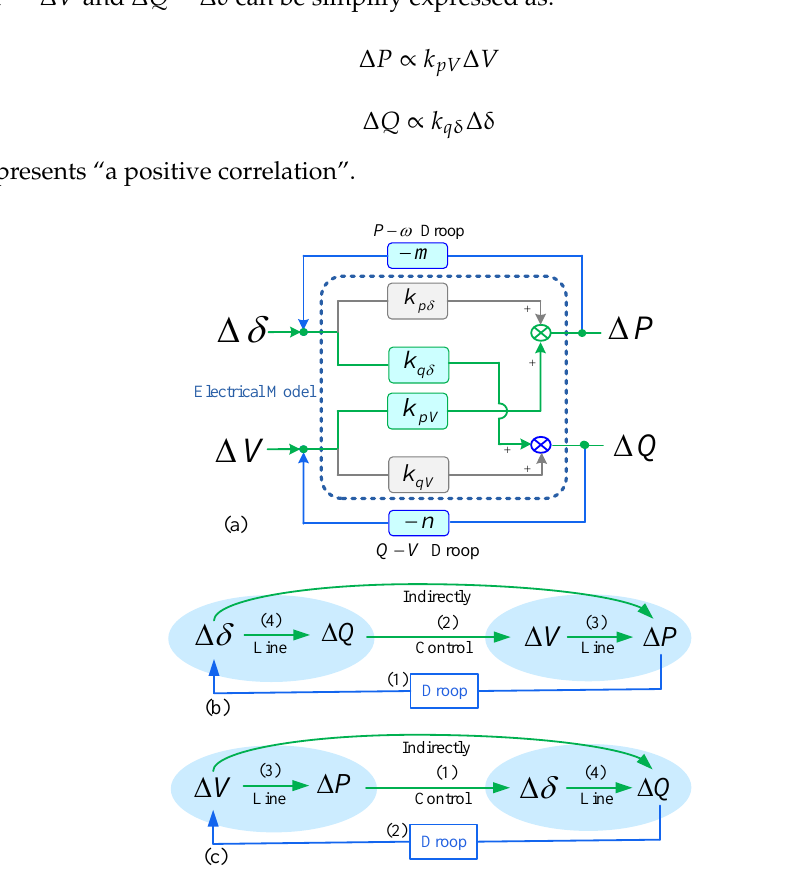
Figure 3. The coupling relationship: ( a ) the whole small signal model; ( b ) active power control; and ( c ) reactive power control.